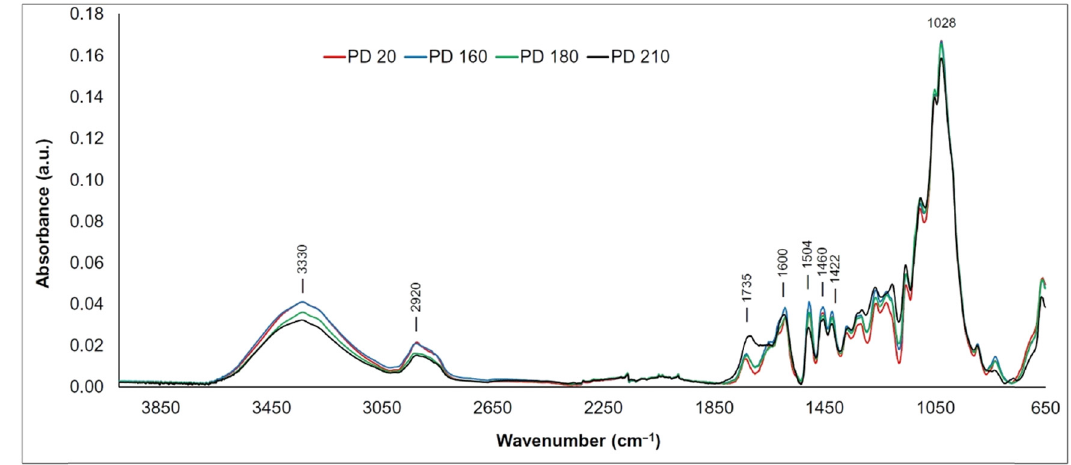
Figure 5: FTIR spectra of the thermally treated African padauk wood.